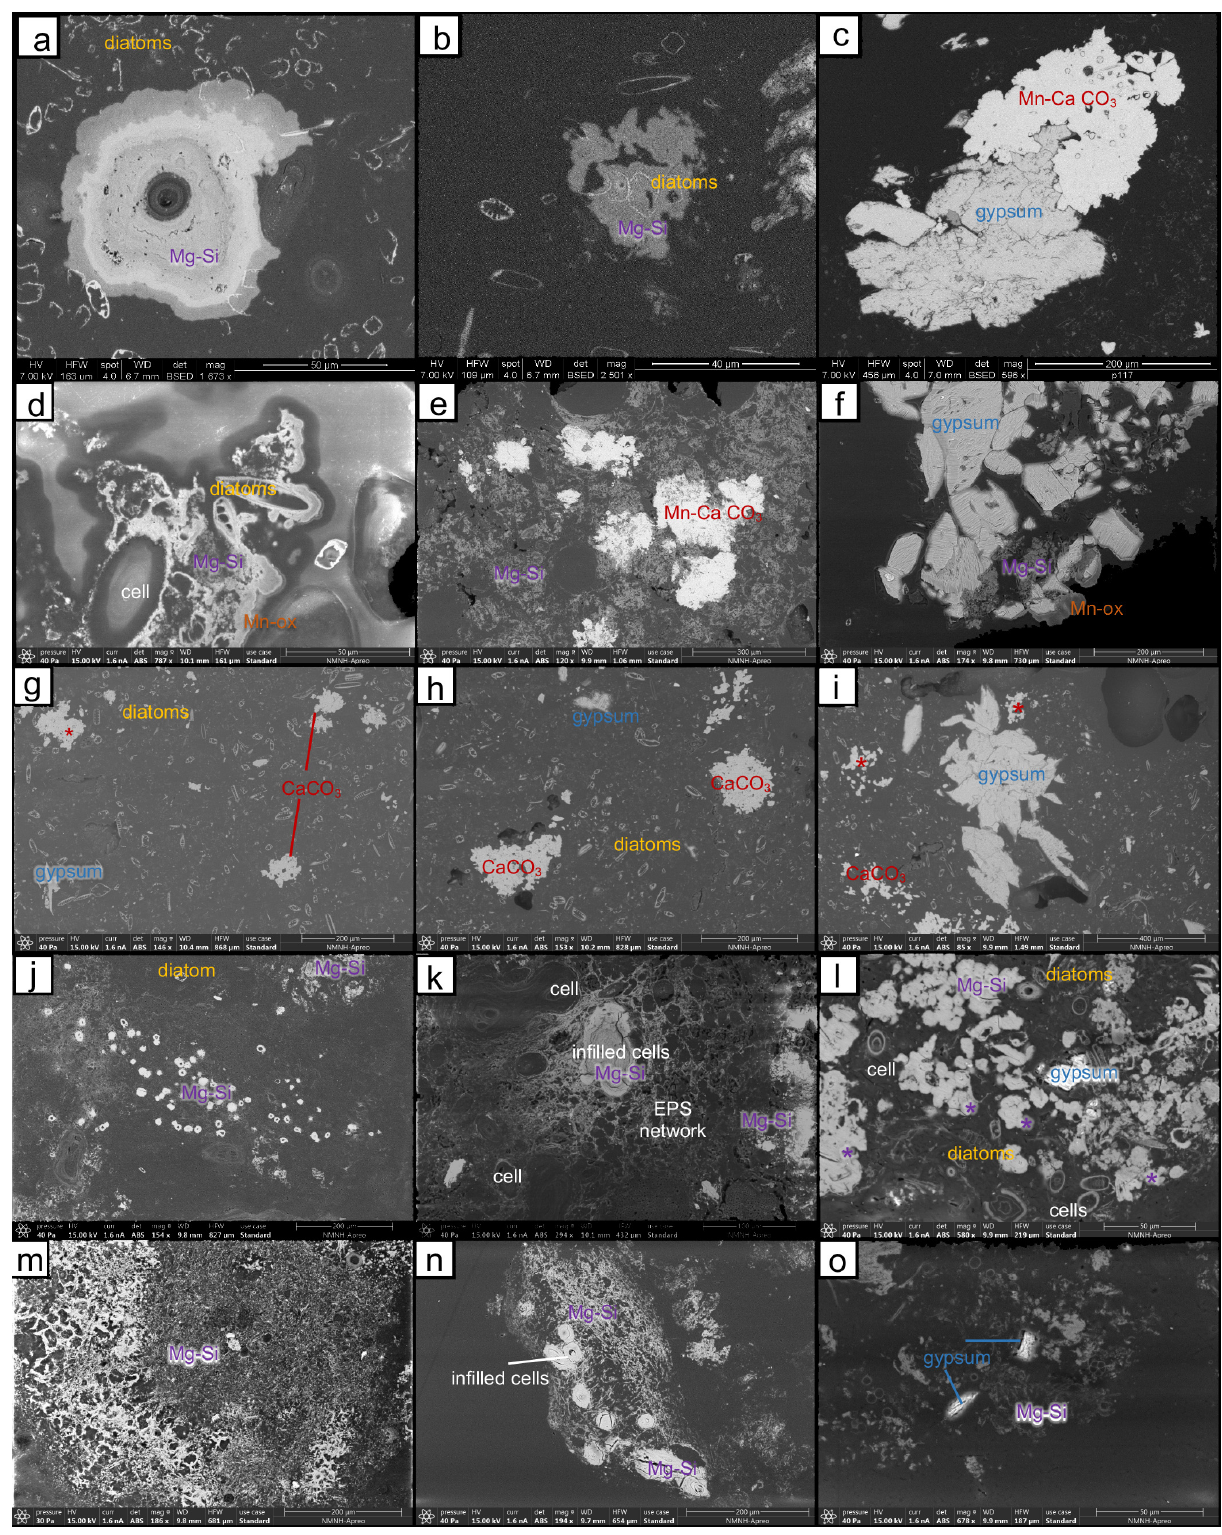
Figure 5. SEM images (backscatter mode) of bottom types in the Puquios collected in March 2019. Black domes: ( a ) cross section of a bacterial cell sheath surrounded by Mg–Si, diatom frustules at various stages of degradation are also present around the cell; ( b ) diatom frustules within and around the Mg–Si; ( c ) Mn-rich CaCO 3 forming around a grain of gypsum. Black semi-cohesive mat: ( d ) cross section of a bacterial cell sheath and diatom frustules surrounded in Mg–Si and Mn-oxide; ( e ) dense EPS network coated in Mg–Si with pore space infilled with Mn-rich CaCO 3 ; ( f ) anhedral to subhedral gypsum grains surrounded by Mg–Si and Mn-oxide. Floccules: ( g ) small irregularly